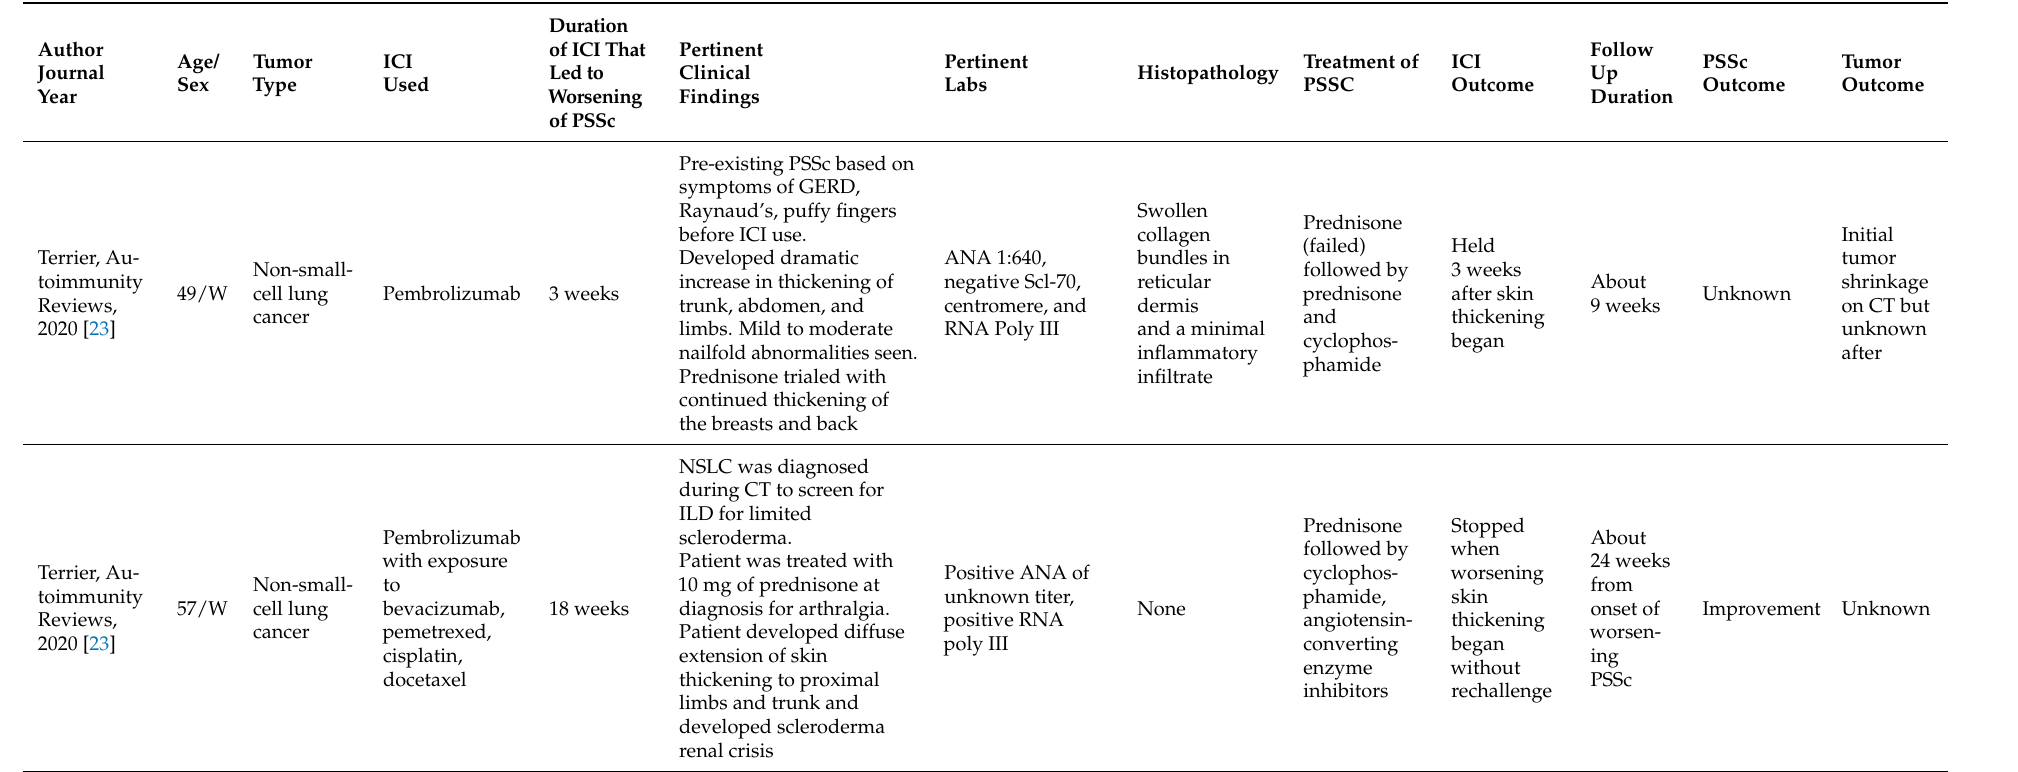
Table 2. Immune checkpoint inhibitor use in preexisting scleroderma